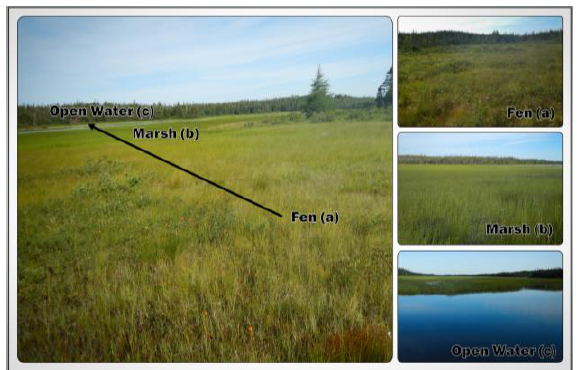
Figure 3. A fen (a), marsh (b), and open-water (c) wetland transition near Conne River, 209 Figure 3. A fen ( a ), marsh ( b ), and open-water ( c ) wetland transition near Conne River, Newfoundland Newfoundland and Labrador, Canada. 210 and Labrador,